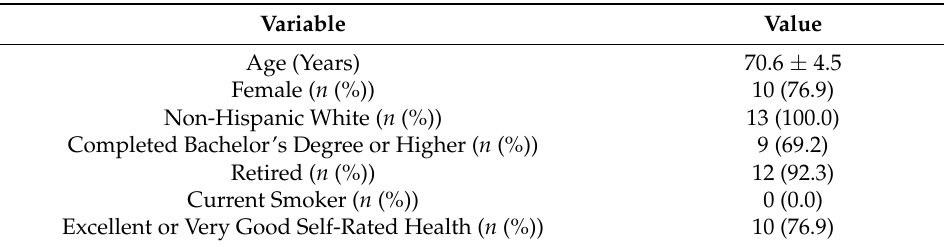
Table 2. Descriptive Characteristics of the